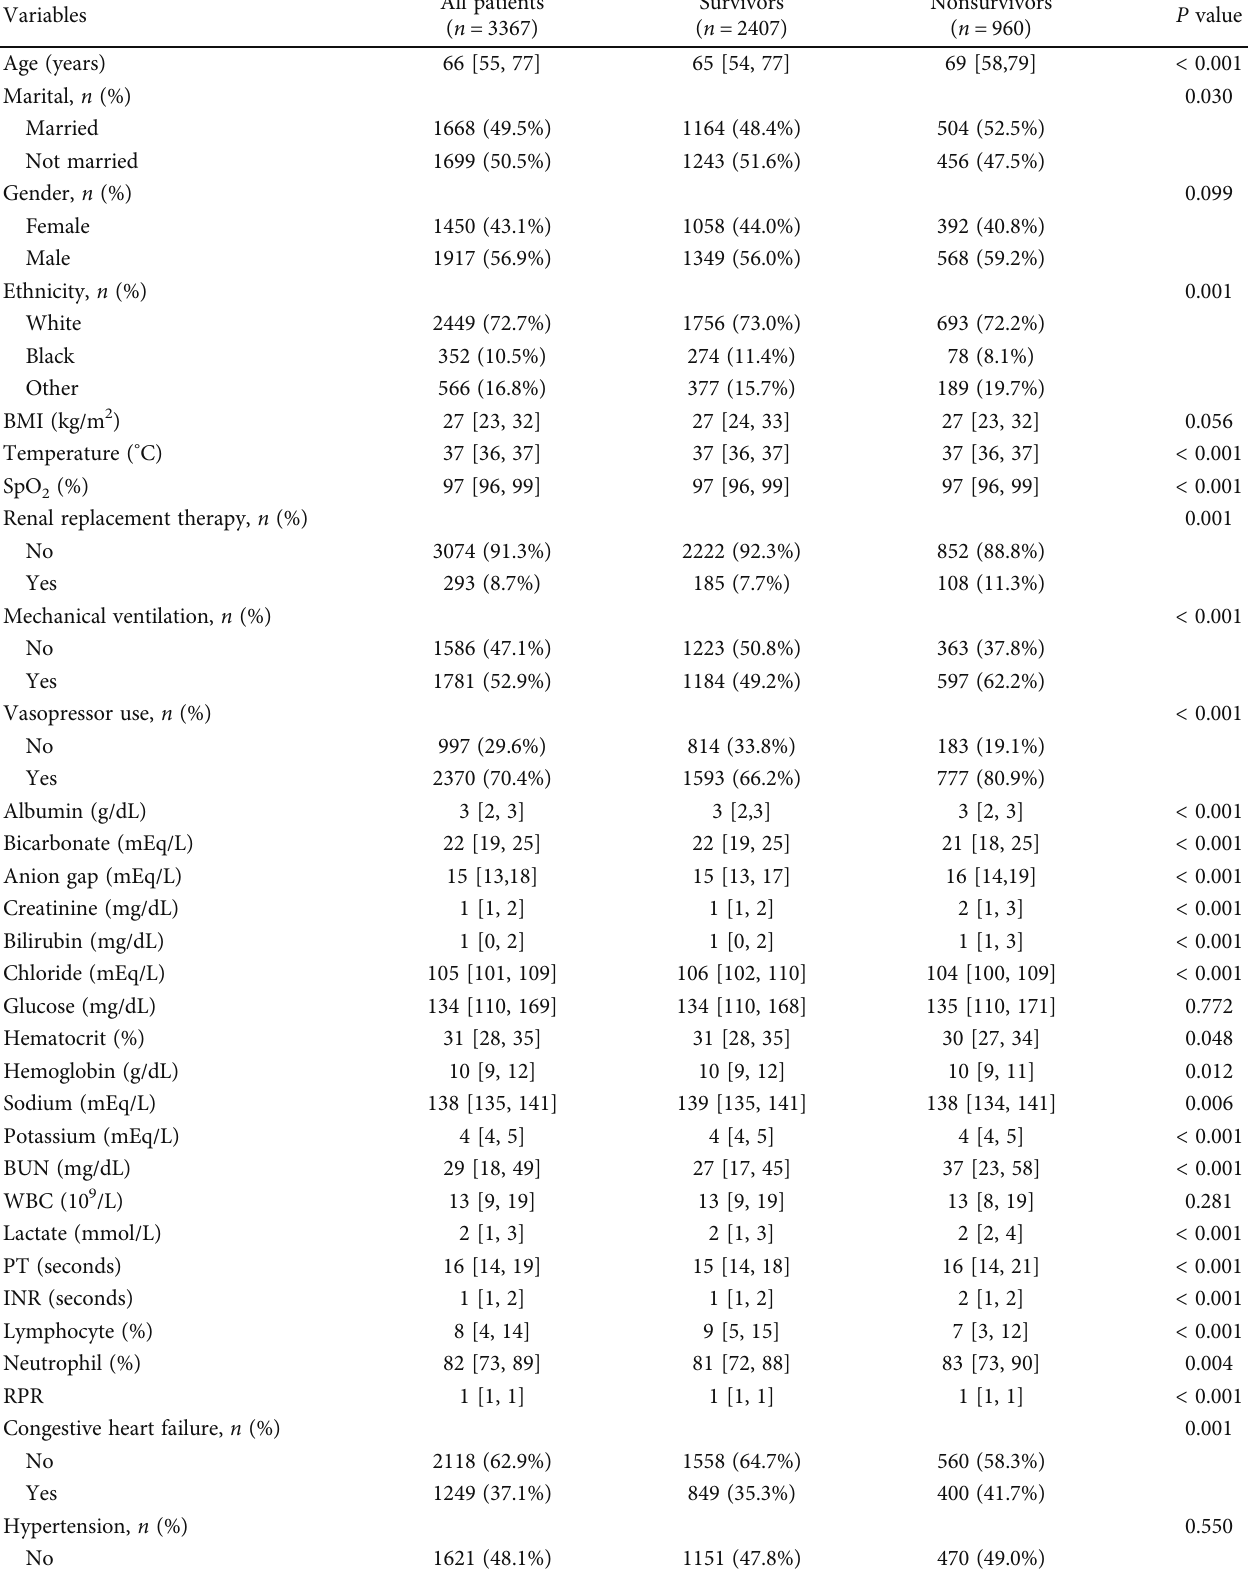
Table 1: Comparison of baseline characteristics between 28-day survivors and